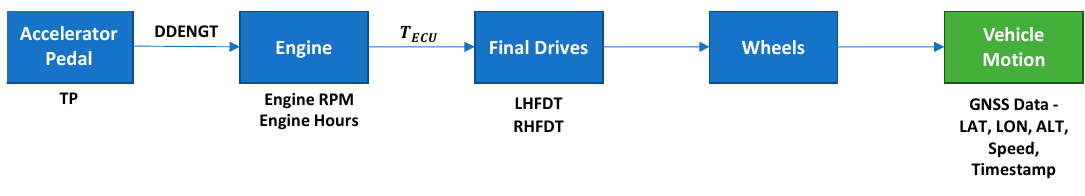
Figure 3. Overview of APC power train.